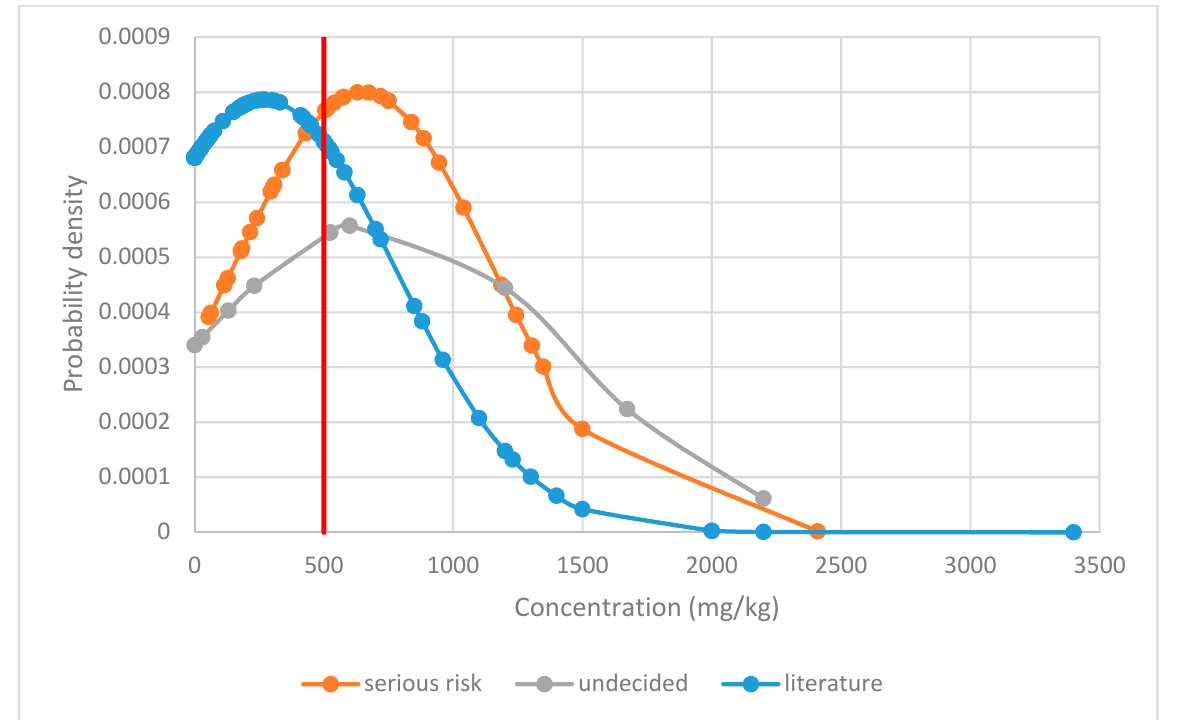
Figure 2. Normal probability distribution of Δ 9 -tetrahydrocannabinol levels in food supplements comparing data from the RASFF system assessed as being of serious risk and undecided risk level with literature data [11]. The red line marks the suggested level above which a serious risk can be typically assumed.